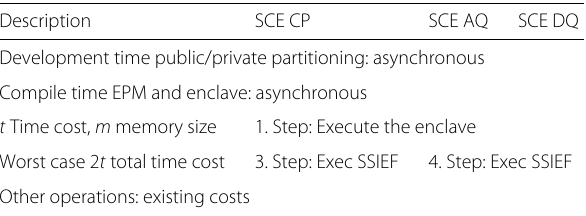
Table 7 Overhead of three use cases on secret-code execution Description SCE CP SCE AQ SCE